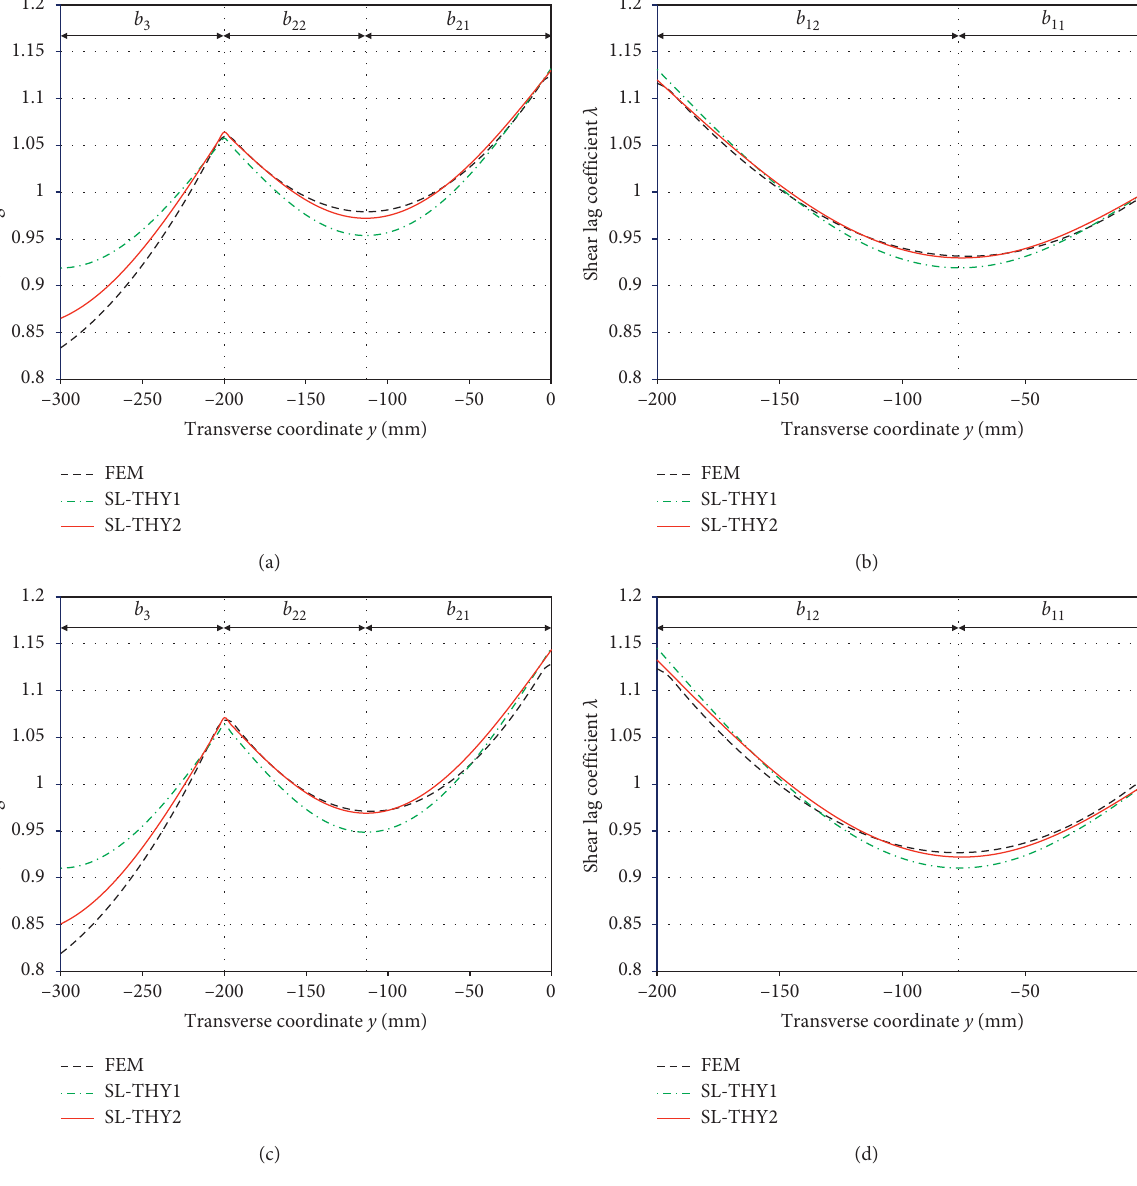
Figure 9: Shear lag coefficients of the simply supported box girder. (a) Top flanges of midspan cross section ( x � 450 mm). (b) Bottom flanges of midspan cross section ( x � 450mm). (c) Top flanges of 1/3-span cross section ( x � 300mm). (d) Bottom flanges of 1/3-span cross section ( x �